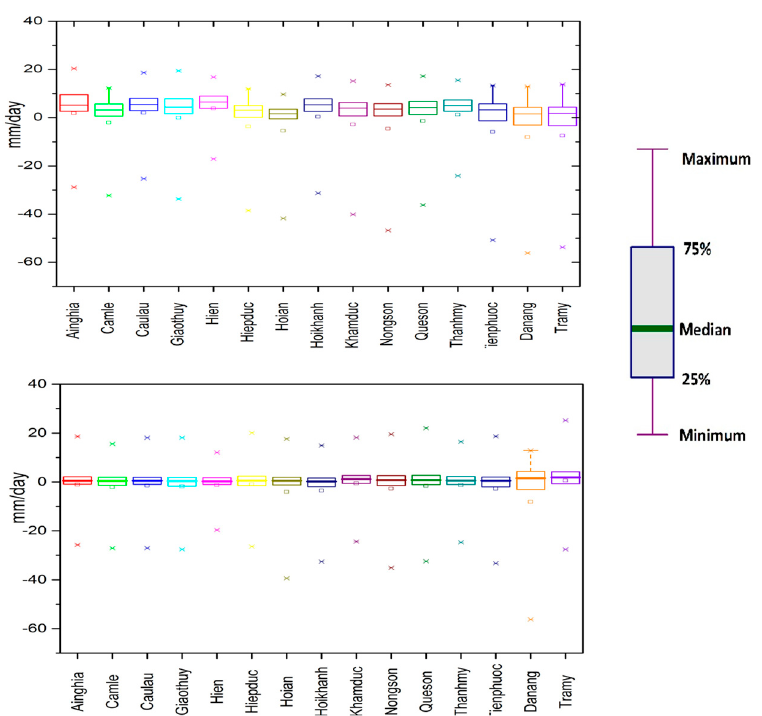
Figure 5. Box plot of the day of year of precipitation before ( top ) and after ( bottom ) bias correction minus measured data for 15 stations in VG-TB basin during 1986–2005 (mm/day).